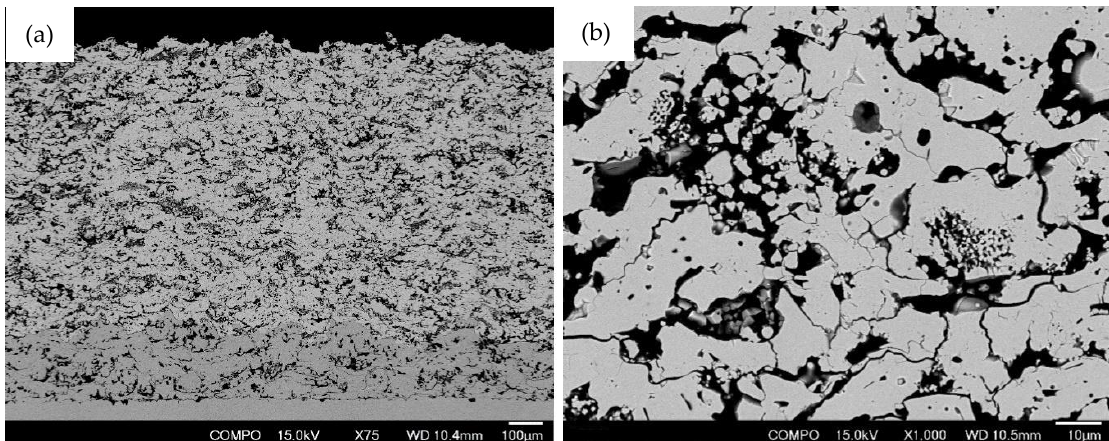
Figure 4. Microstructure cross-section of the coating produced with experimental Low-Density powder. Overall coating ( a ) and high-magnification images ( b ).